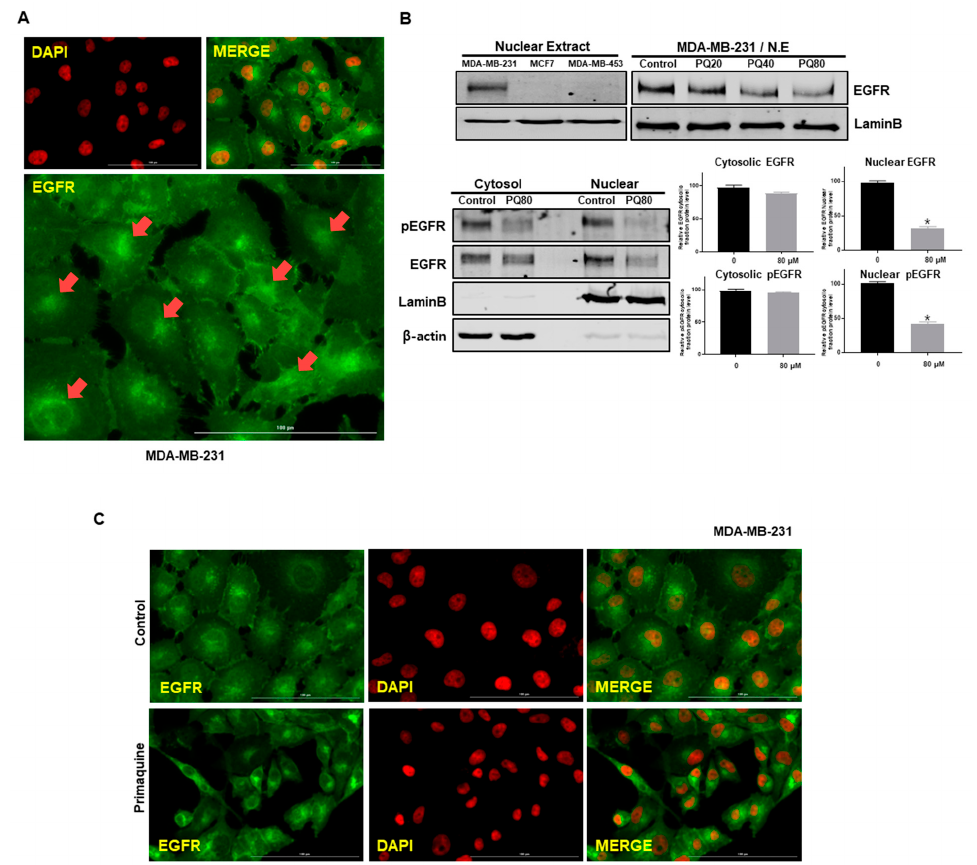
Figure 3. nEGFR expression was reduced in MDA-MB-231 cells upon primaquine treatment. ( A ) Nuclear localization of EGFR with anti-EGFR (green) and nuclei (red, DAPI) using a fluorescence microscope (Lionheart FX, BioTek, Winooski, VT, USA). nEGFR resulted from merging of EGFR (green) and DAPI (red). ( B ) MCF-7, MDA-MB-453, and MDA-MB-231 cells were treated with primaquine (20, 40, and 80 µ M) for 24 h and subjected to Western blot analysis. Cells were finally lysed, and cytosolic and nuclear proteins were isolated. The cytosolic and nuclear proteins were identified with anti-pEGFR and anti-EGFR antibodies by Western blotting. The expression of lamin B and β -actin were determined as a loading control for nuclear and cytosolic lysates. Values are the mean ± SD of 3 independent experiments. * indicates p < 0.05 vs. control. ( C ) Cancer cells with/without primaquine were washed, fixed, permeabilized, and blocked with 0.1% normal goat serum for 60 min. Cells were incubated with primary monoclonal EGFR antibody. Immunostained cells were examined with a fluorescence microscope (Lionheart FX, BioTek, Winooski, VT, USA). Red, nuclei stained by DAPI; green, EGFR. nEGFR was identified by merging EGFR (green) and DAPI (red)